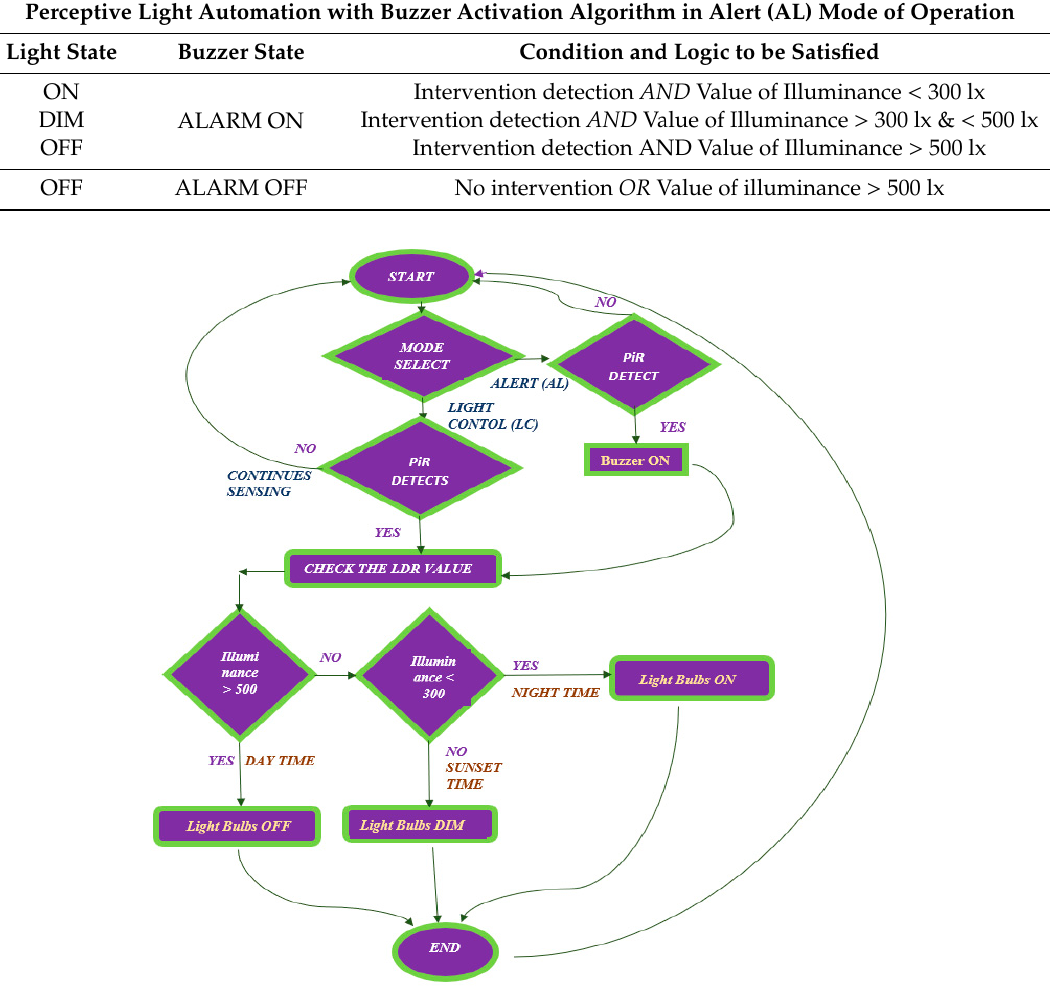
Table 5. Condition and logic to be satisfied for PLABA.